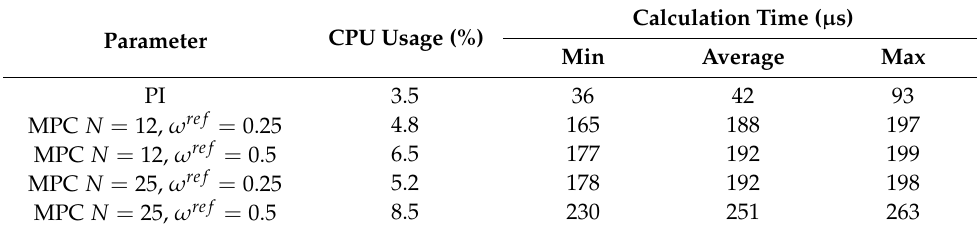
Table 3. Comparison of program execution times by the PLC controller.